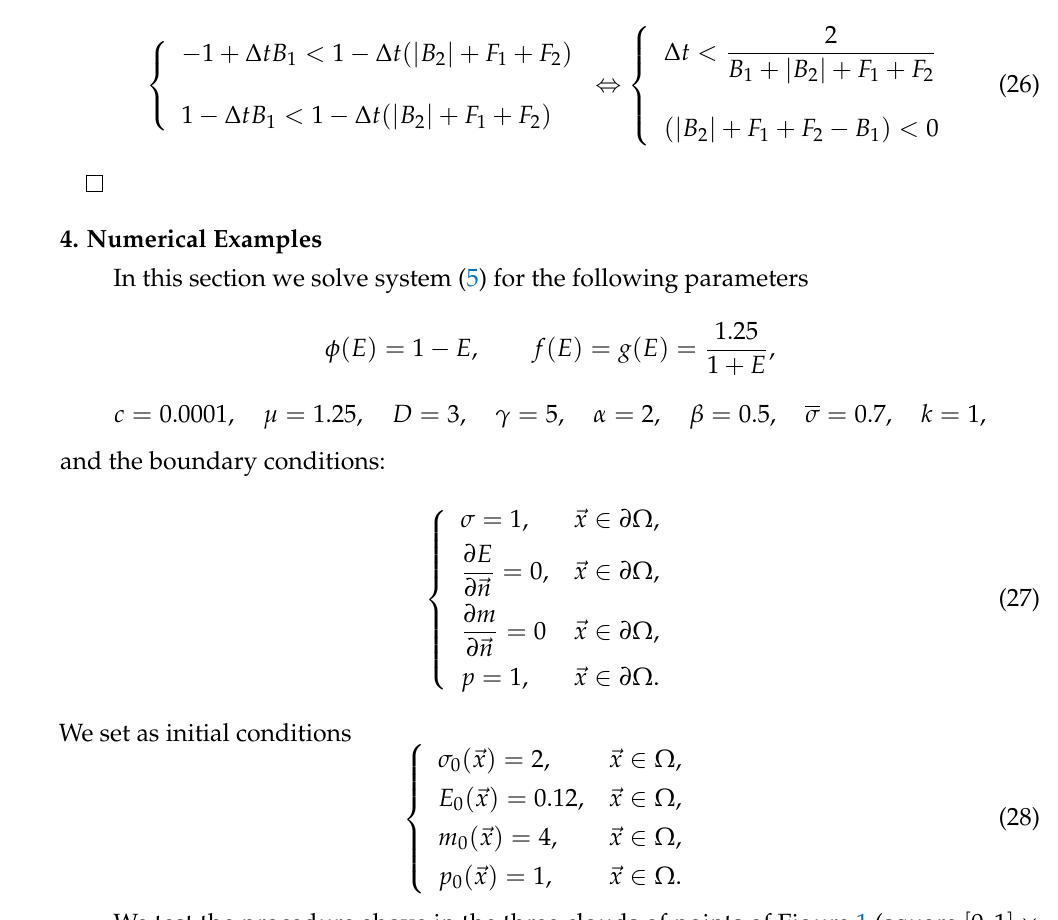
been represented in the x − y plane and in the z -axis the values obtained for the previous mentioned functions, i.e., σ , E , m and p